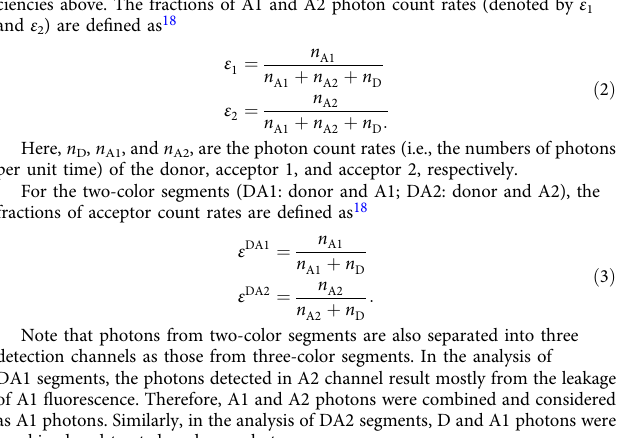
where ε F and ε U are the fractions of acceptor photons of the folded and unfolded states de fi ned in Eq. (3), and p F = k F /( k F + k U ) is the equilibrium population of the folded state. k F and k U are the folding and unfolding rate coef fi cients. For a three-color segment, F (acceptor 1) = E 1 , F (acceptor 2) = E 2 , and F (donor) = I − E 1 − E 2 , where E 1 and E 2 are the diagonal matrices with the fractions of acceptor 1 (A1) and acceptor 2 (A2) photons de fi ned in Eq. (2). In the case of protein folding experiment, all three dyes are attached to the same molecule. Two- and three-color segments are independent, so the corresponding likelihoods can be calculated separately. The total likelihood is the product of individual ones with different dye combinations (i.e., L = L (3c) L (DA1) L (DA2) ). (If photobleaching or slow blinking of one acceptor occurs, the three-color segment and two-color segment before and after photobleaching are not independent, but this effect would be negligible in the parameter determination.) This likelihood function is optimized with respect